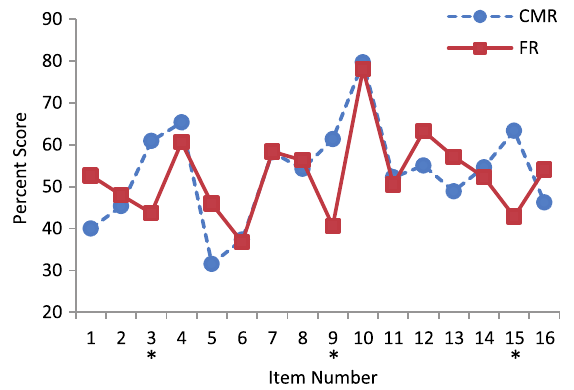
FIG. 4. Average scores on each item on the CUE. Statistically significant differences between the CMR and FR versions are indicated by an asterisk (Mann-Whitney, p > 0 . 05 ). All questions are available from Ref.